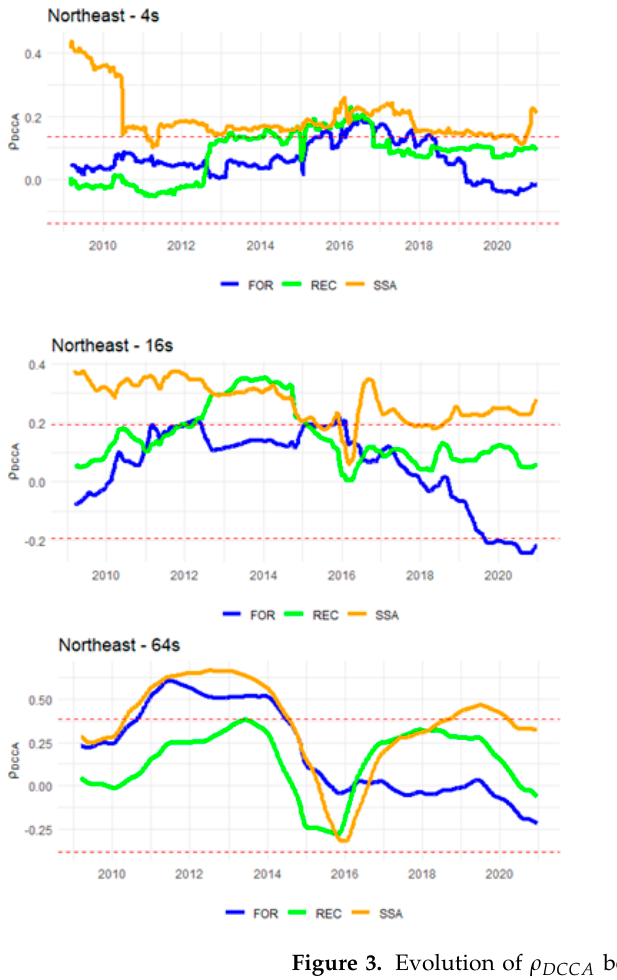
Figure 3. Evolution of ρ DCCA between the relative prices of S ã o Paulo and other capitals in the Northeast Region, with time scales of 4, 8, 16, 32 and 64 weeks, and moving window w = 250. Shaded lines are the upper and lower confidence intervals, in the sense that values between these are not statistically significant, according to the critical values of [66].